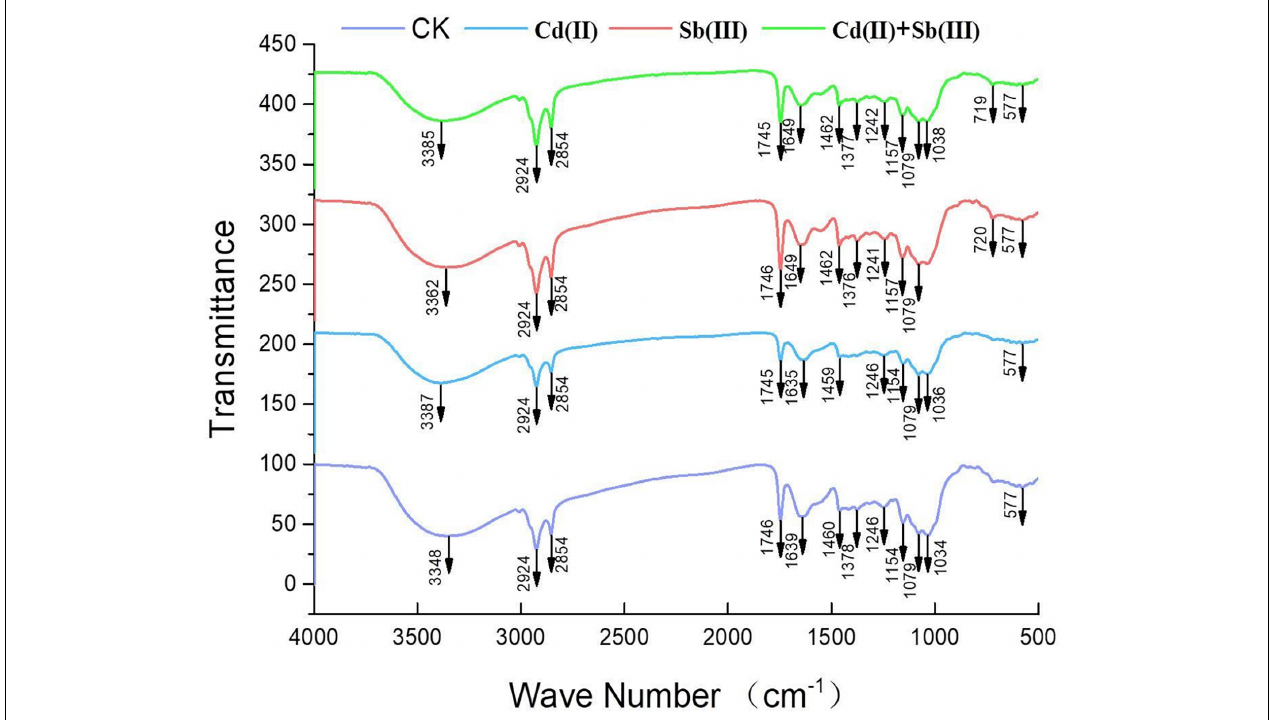
FIGURE 8 | FTIR spectra of XK8 biomass before and after heavy metal